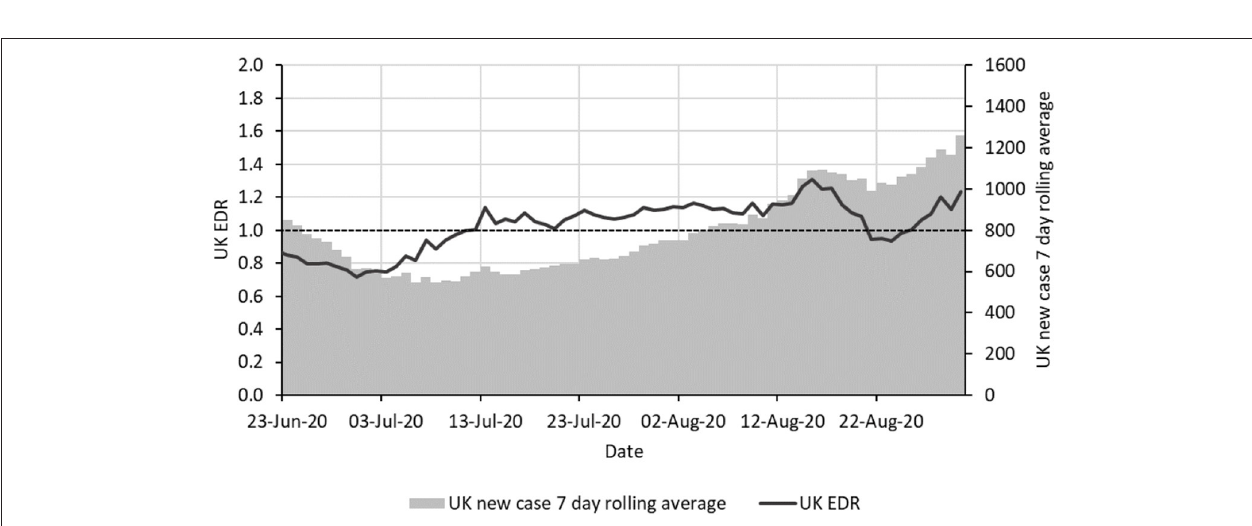
FIGURE 1 | Epidemic curve and EDR for the COVID-19 epidemic in the UK from 1 March to 20 April 2020. The epidemic curve is indicated as vertical bars giving a 7-day moving average of new cases. The solid line shows the EDR estimated using periods of 7 days. The horizontal dashed line shows the boundary with EDR = 1.